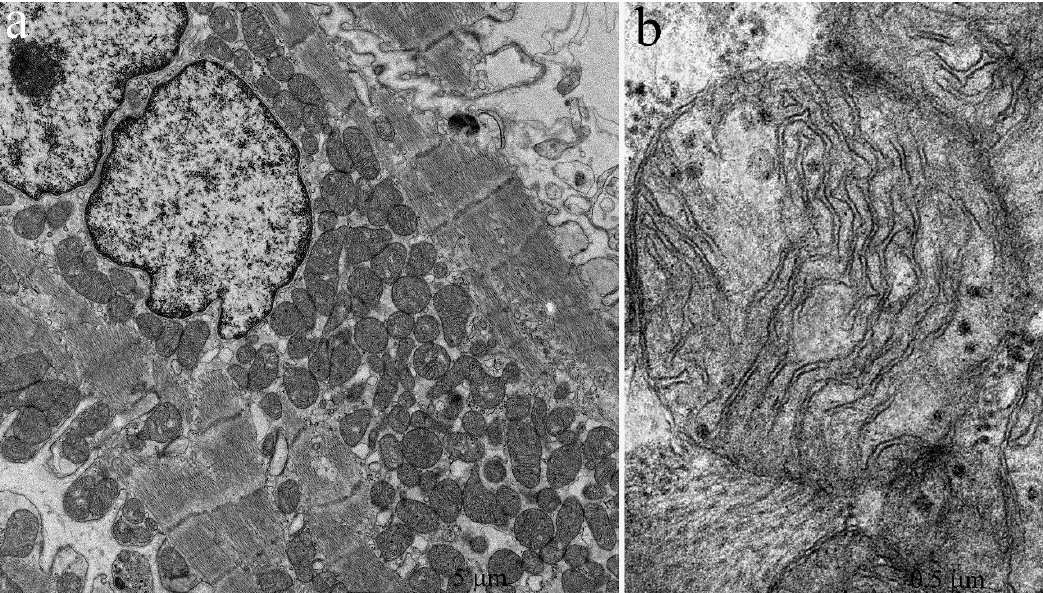
Figure 4. Electron microscopic images of the ultrastructure of a left ventricular cardiomyocyte from a three-year-old naked mole rat: ( a ) General view at low magnification. Mitochondrial aggregates in perinuclear area are observed. ( b ) Ultrastructure of a single mitochondrion at higher magnification.